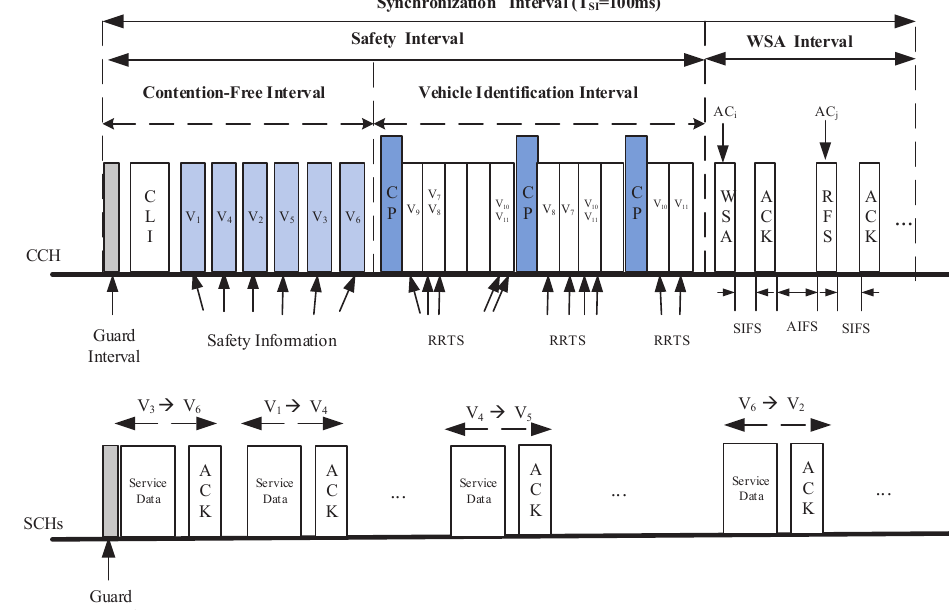
Figure 1. The framework of EQM-MAC protocol.